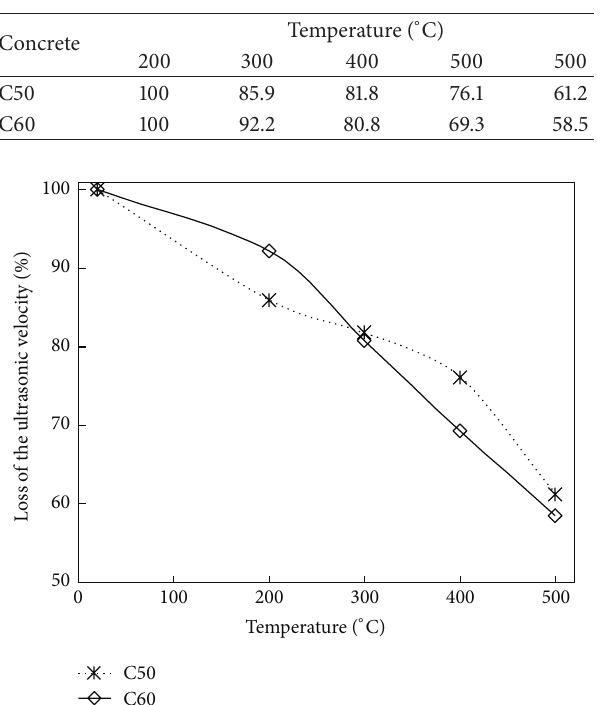
Table 6: Loss of the ultrasonic velocity of HPC at elevated temper- ature.